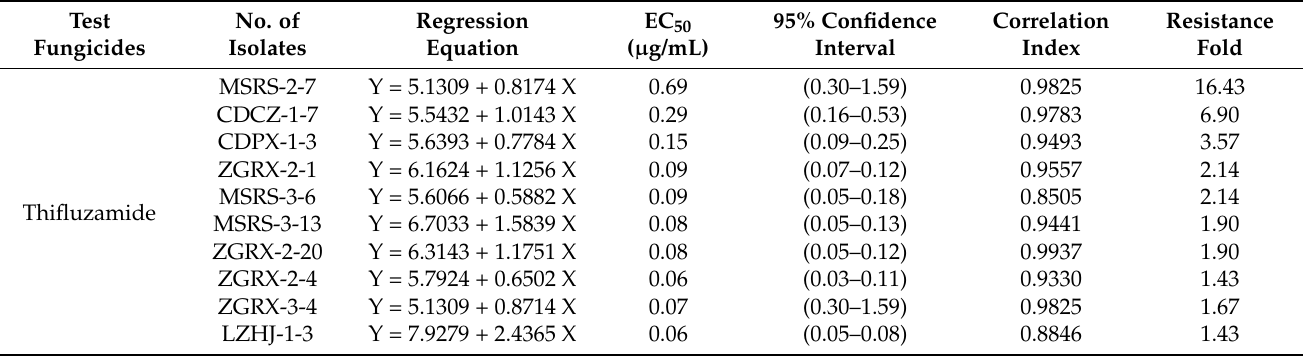
Table 3. Determination of resistance levels of R. solani isolates to four tested